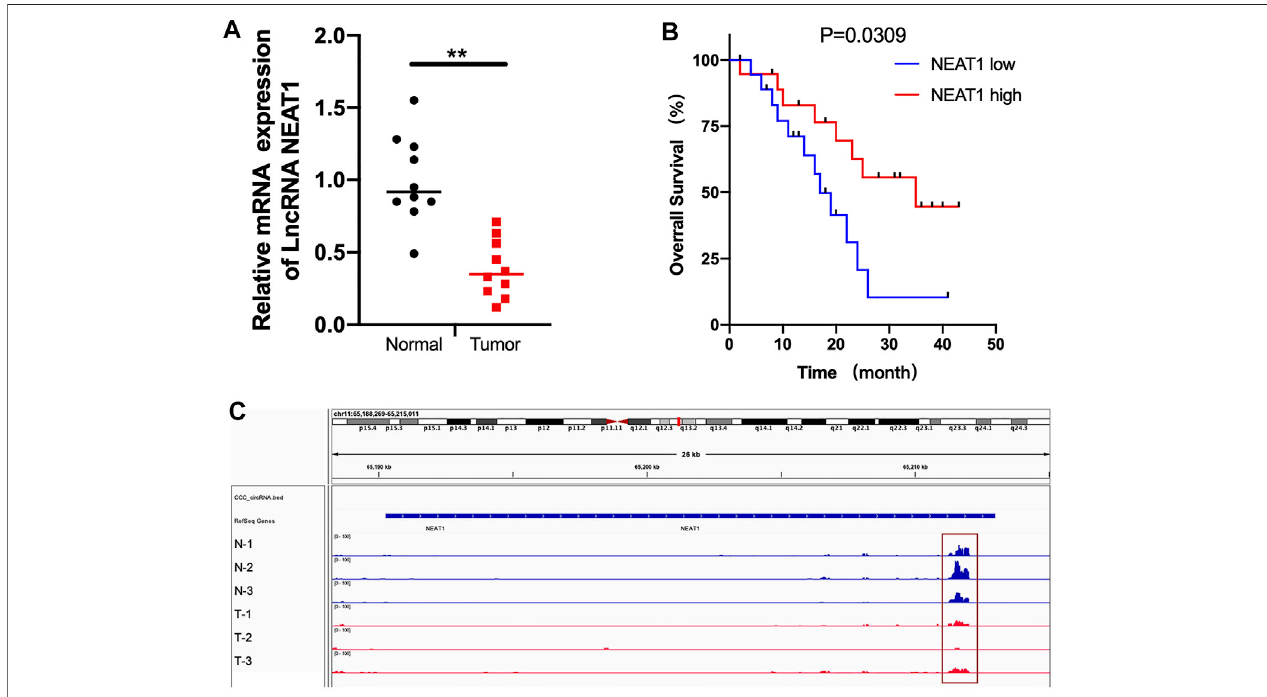
FIGURE 1 | The mRNA and m6A methylation level of LncRNA NEAT1 was obviously decreased in RCC tissues. (A) LncRNA NEAT1 expression levels in RCC tumors and normal tissues. (B) The Kaplan – Meier survival curves of LncRNA NEAT1 in RCC tissues. (C) The m6A abundances on LncRNA NEAT1 exon in 3 pairs of RCC tumor and adjacent tissues by